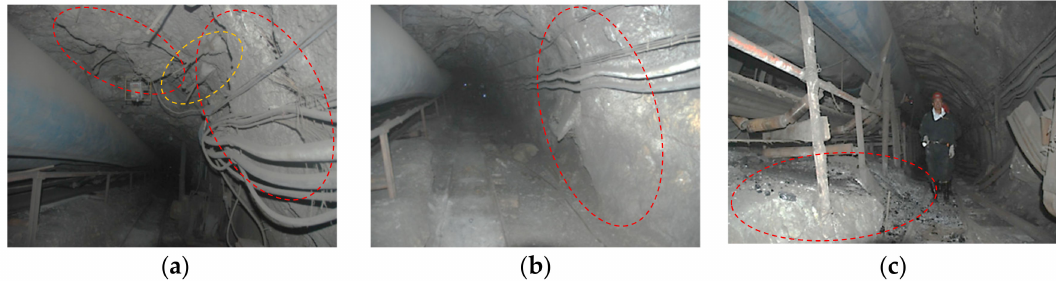
Figure 6. Asymmetric failure mode in the coal roadway [23]: ( a ) asymmetrical roof shrinkage deformation and support failure; ( b ) asymmetrical side extrusion deformation; ( c ) asymmetrical floor heave deformation.